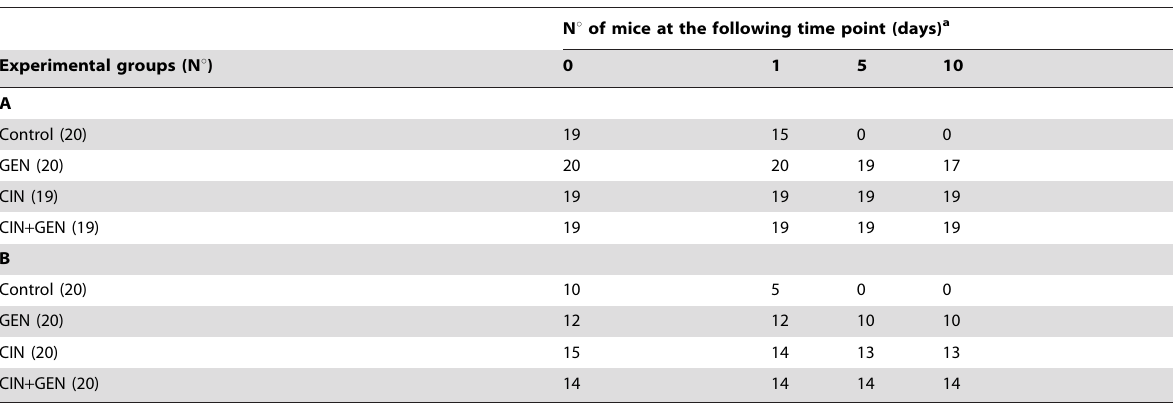
N u of mice at the following time point (days) a